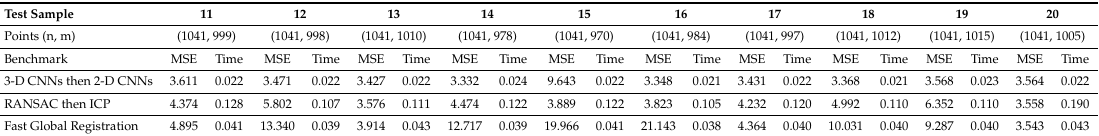
Table 6. The comparisons about MSE and computation time of “Dragon” data for test samples from 11 to 20.